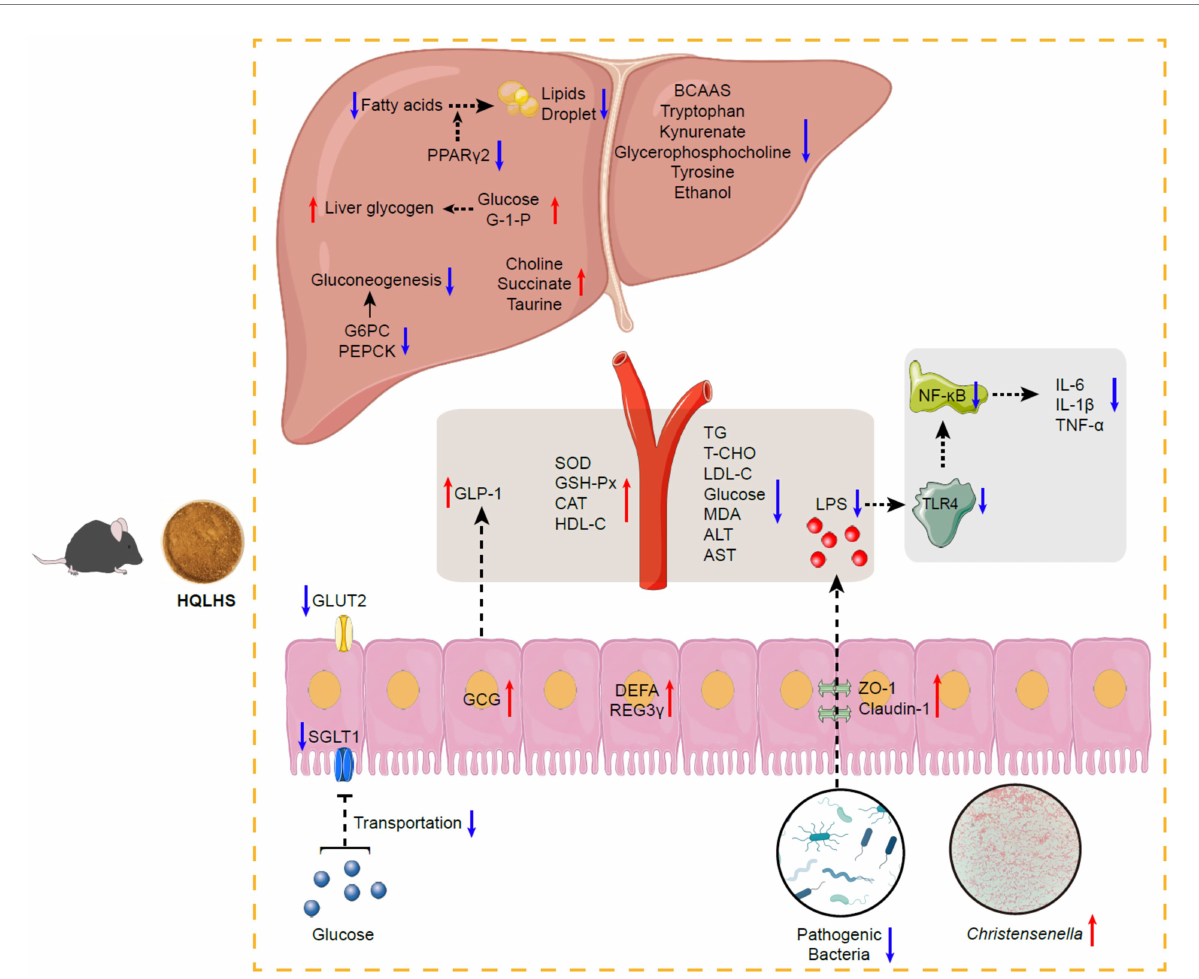
FIGURE 7 Schematic diagram showing the possible mechanisms of Huang-Qi-Ling-Hua-San ameliorating type 2 diabetes via Christensenella . HQLHS treatment inhibited harmful bacteria and enriched beneficial bacteria, especially Christensenella . Christensenella promoted the production of GLP-1; Reduced the expression of GLUT2 and SGLT1, thereby inhibiting the transport of glucose in the small intestine; Increased the expression of ZO-1 and Claudin-1, thus decreasing the entry of LPS into the periphery, and reduced inflammation through LPS/TLR4/NF- κ B; Improved the activity of antioxidant enzymes; Decreased the expression of G-6-Pase and PEPCK, which inhibited gluconeogenesis; Increased the synthesis of liver glycogen; Regulated liver metabolites such as BCAAs, tryptophan, kynurenate, and